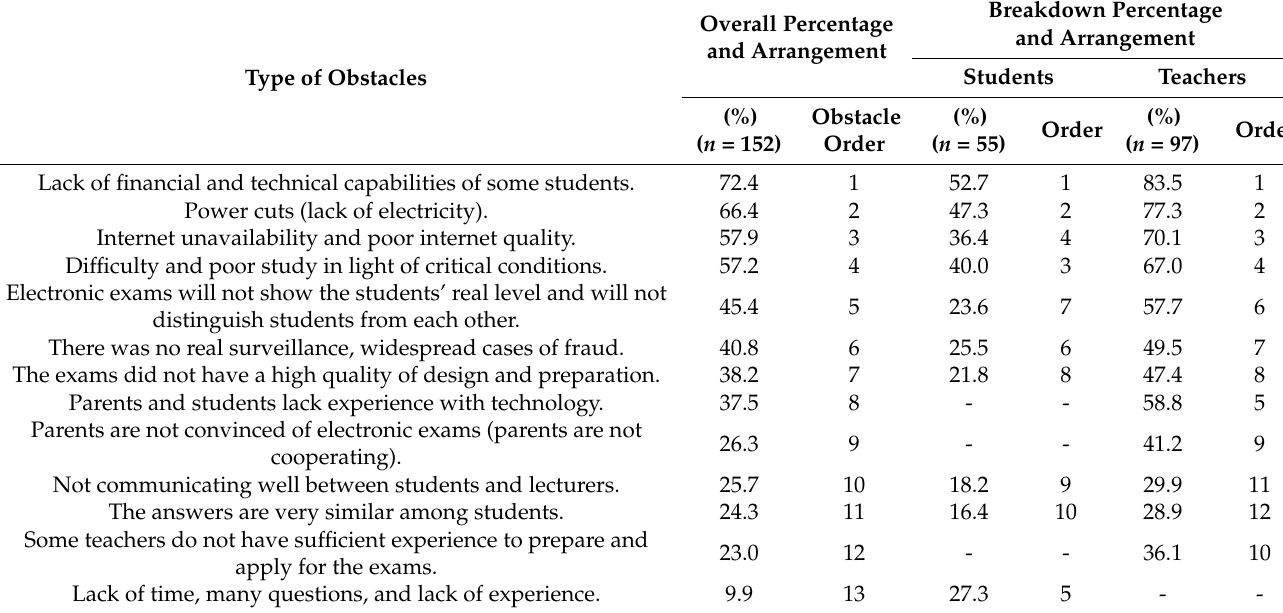
Table 5. Relative significance of electronic exam obstacles for respondents showing overall and breakdown between university teachers and students.